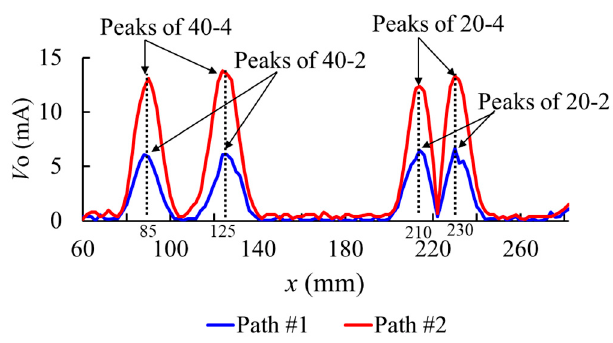
Figure 13. Measurement results of the butterfly probe along paths #1 and #2.